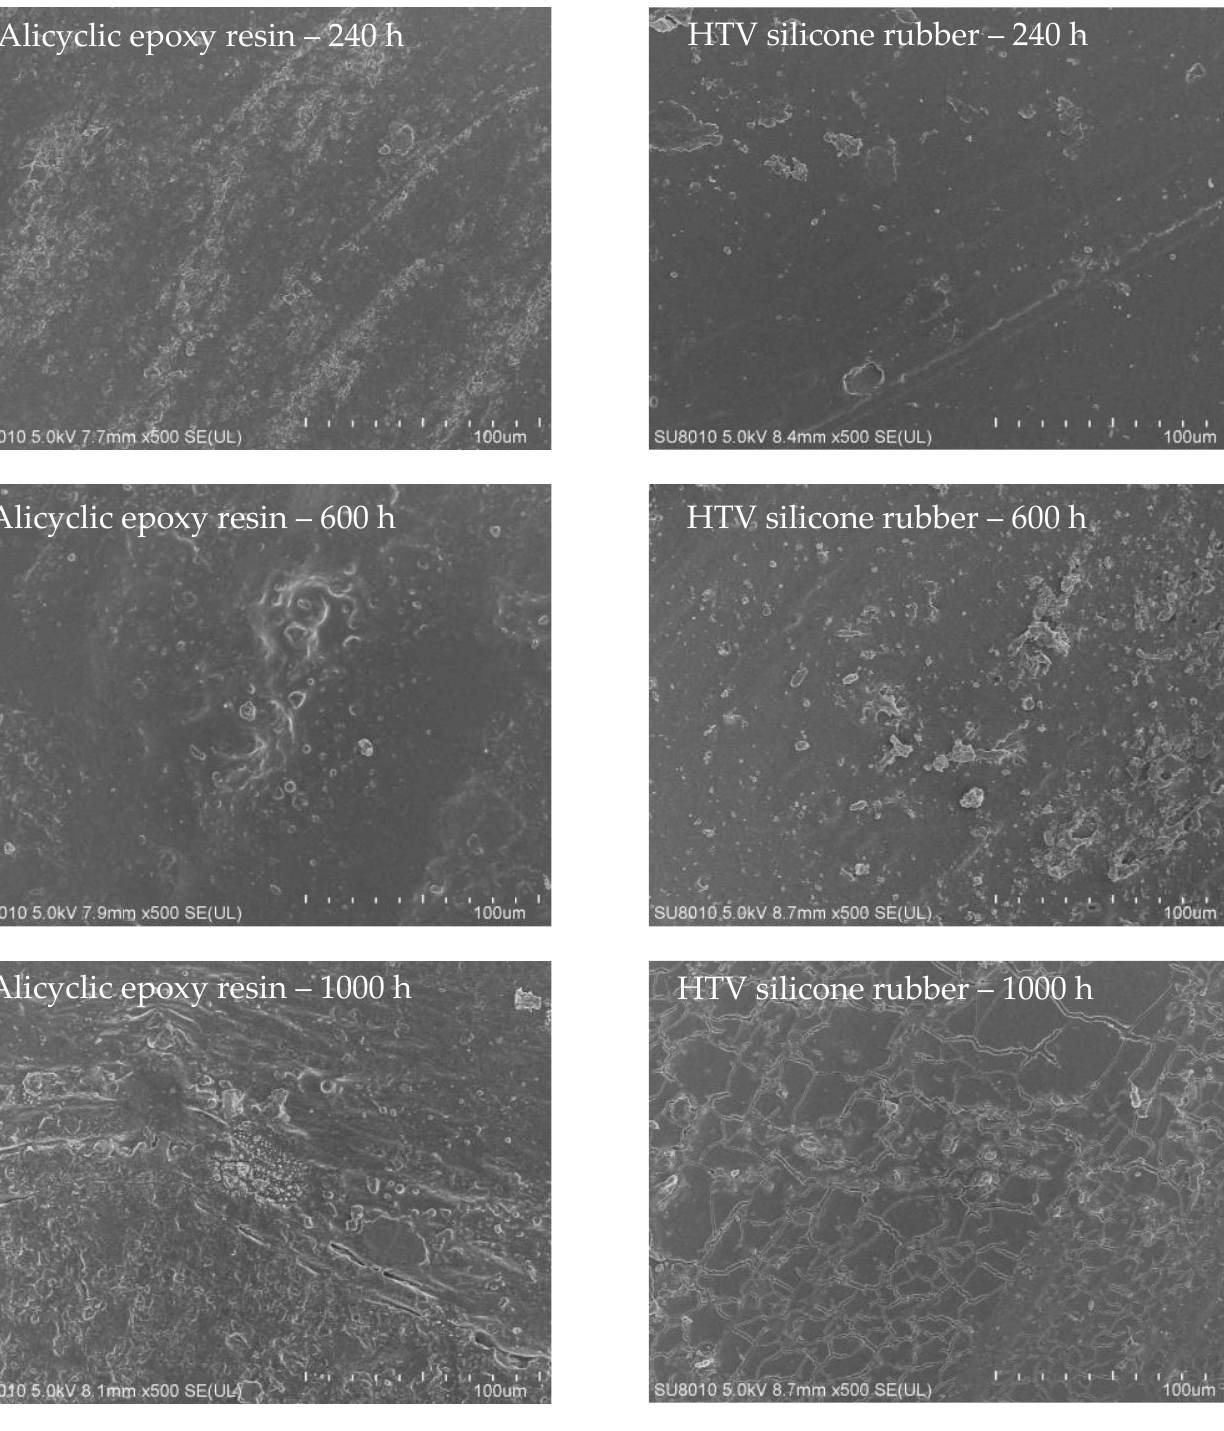
Figure 4. SEM of two samples with different UV-A aging times.